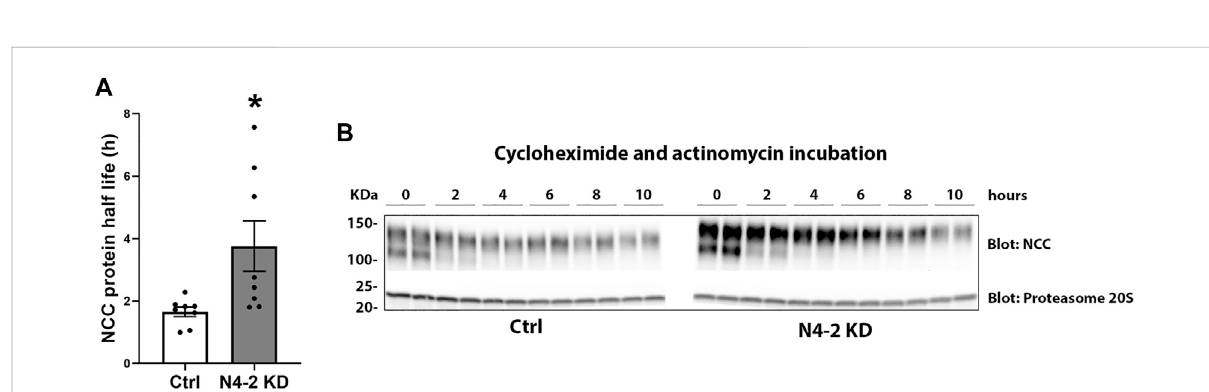
FIGURE 7 NCC half-life is increased with Nedd4-2 de fi ciency in MDCKI-hNCC cells. (A) Semi-quantitative assessment of NCC protein half-life from 8independent experiments.Data aremeans± S.E.M. * p < 0.05 assessed byunpaired Student ’ st-test. (B) Representative immunoblotsofNCC incell lysatesisolatedfromMDCKI-hNCCCtrlandNedd4-2(N4-2)KDcellstreatedwithcycloheximideandactinomycinfortheindicatedtimepoints.Half- lives were calculated for each experiment with a one-phase exponential decay